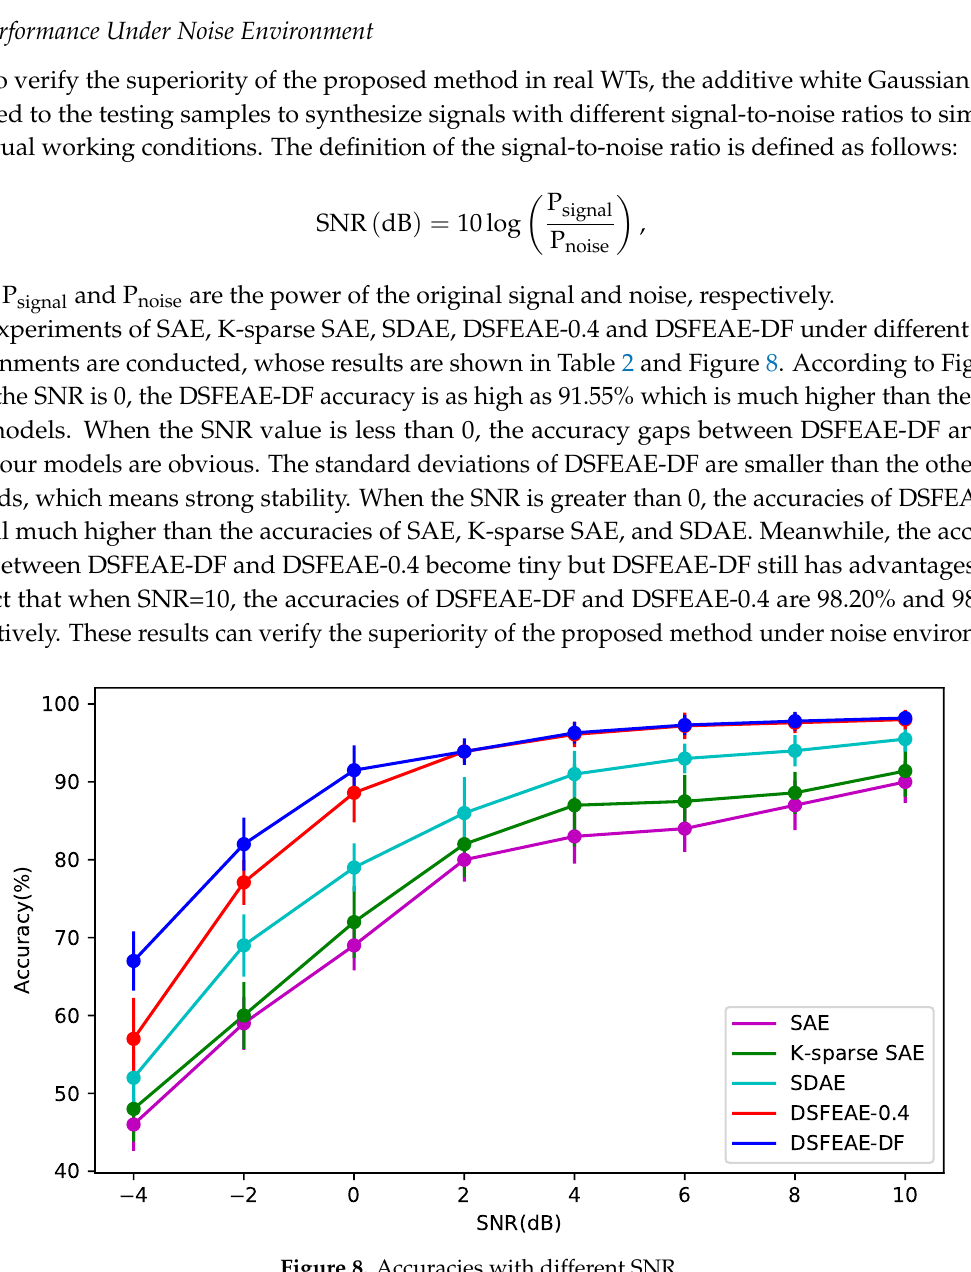
Figure 8. Accuracies with different